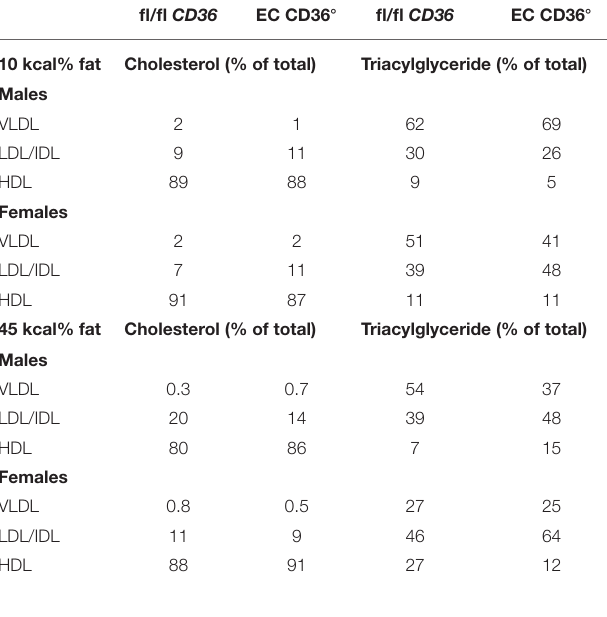
TABLE 1 | Lipoprotein Analysis of Mice Fed With the 10 and 45 kcal % Fat Diets. fl/fl CD36 EC CD36 ◦ fl/fl CD36 EC CD36